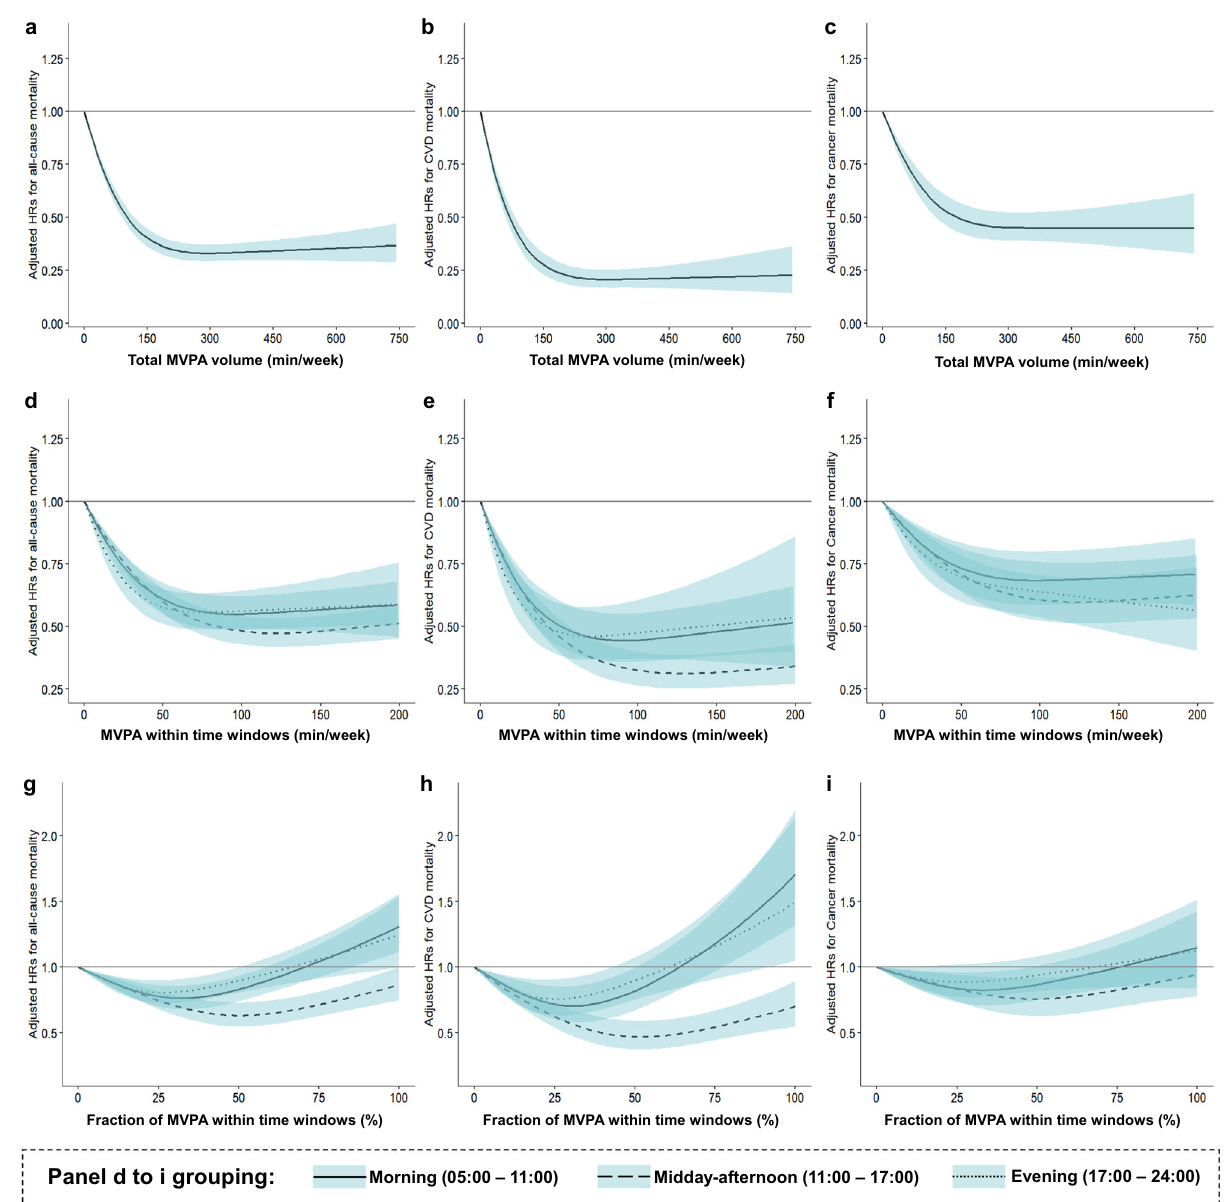
Fig.1|TheassociationsoftotalMVPAvolume,MVPAwithintimewindows,and fractionsofMVPAwithintimewindowswithmortalityrisk.a – c Theassociations between total MVPA volume and mortality outcomes. The hazard ratios (HRs) were adjusted for age, sex, ethnicity, Townsend deprivation index, recruitment